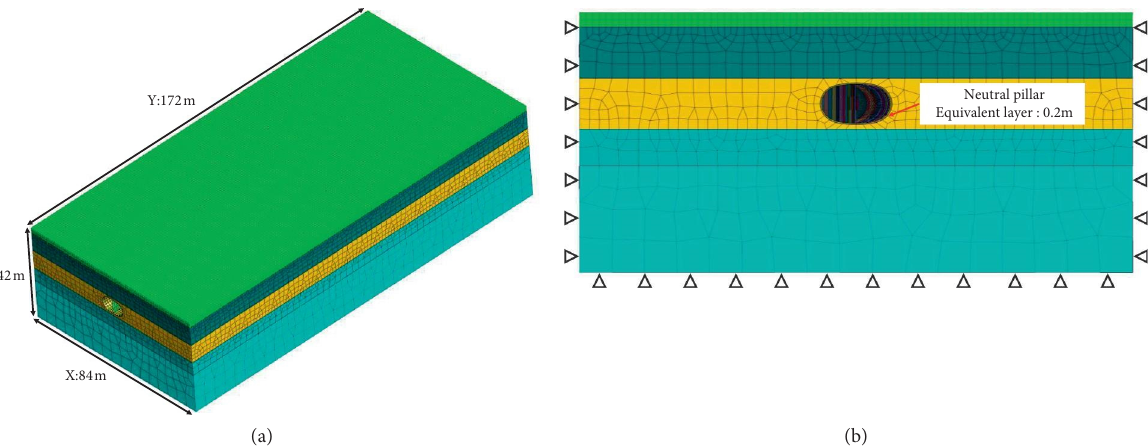
Figure 4: Shield model size and boundary conditions: (a) Shield model size. (b) Shield stratum and boundary